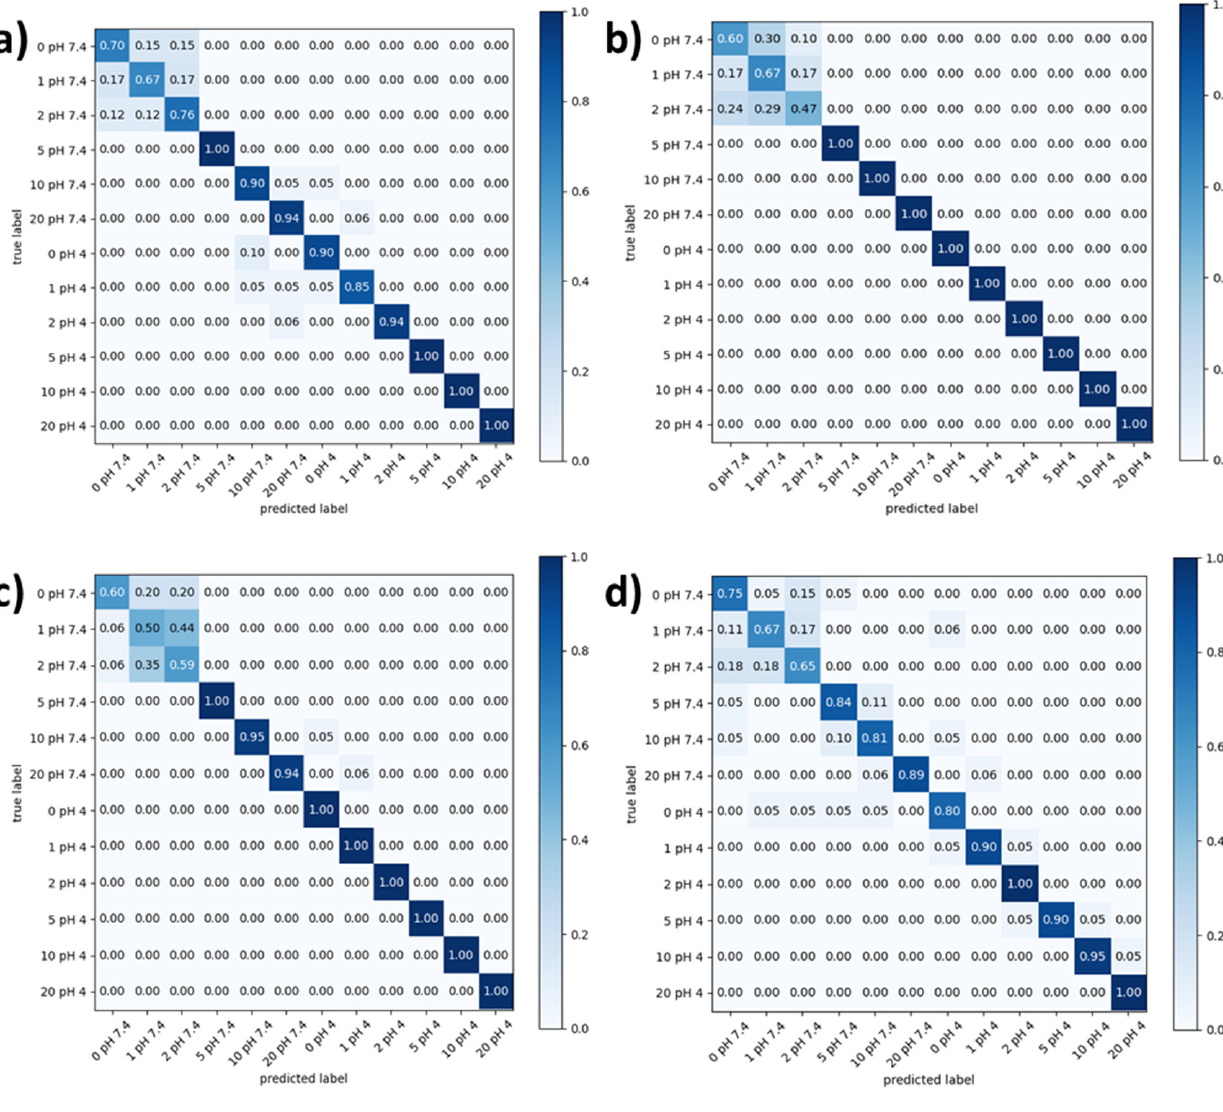
Figure 5. Confusion matrix for twelve classes of copper ion concentration in MEM at different pH conditions using DT ( a ), NB ( b ), SVM ( c ) and ANN ( d ) as classifier.